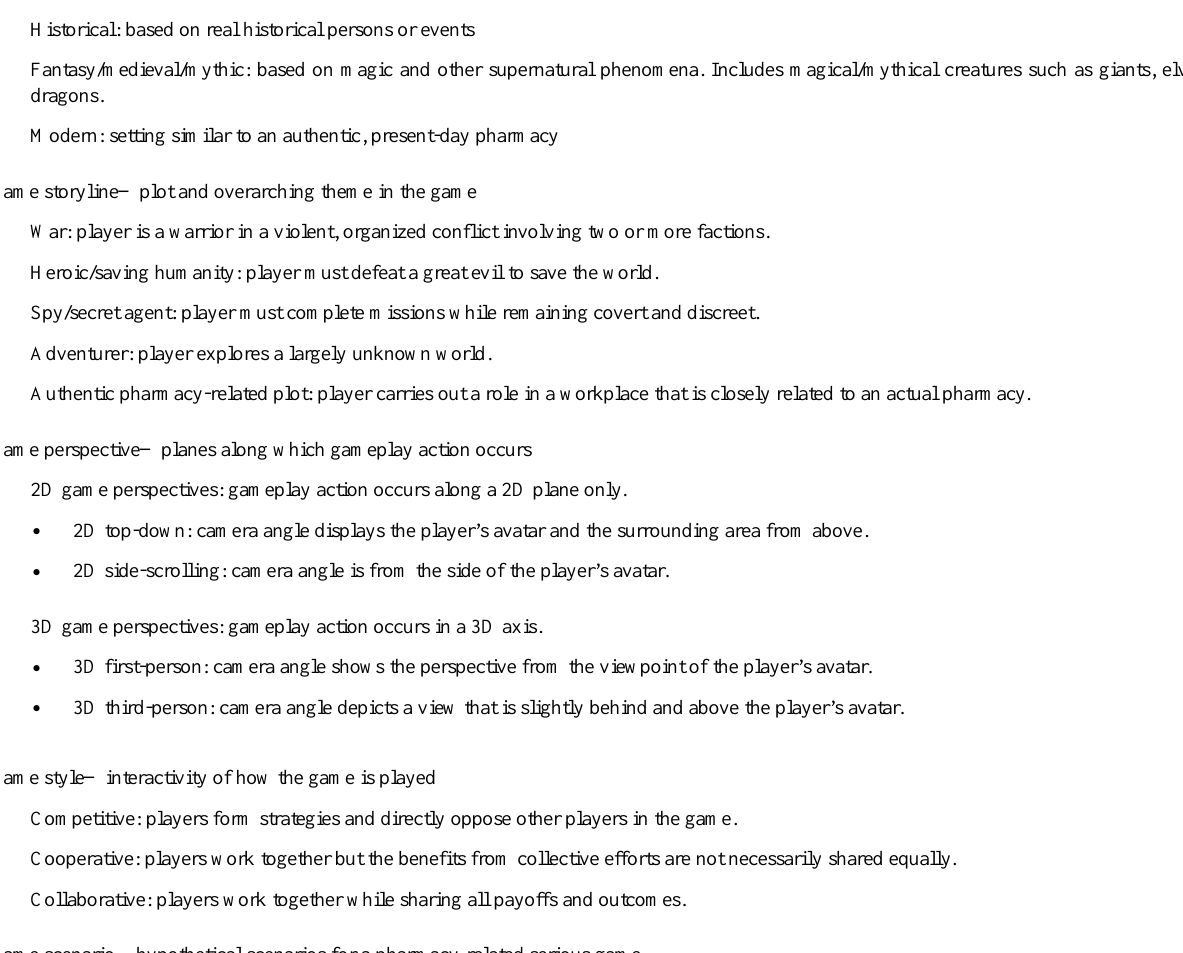
Game scenario—hypothetical scenarios for a pharmacy-related serious